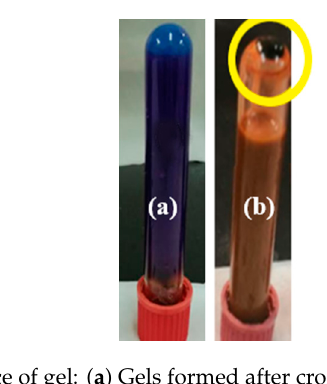
Figure 6. Physical appearance of gel : ( a ) Gels formed after crosslinking 9% PAM/12,000 ppm Co